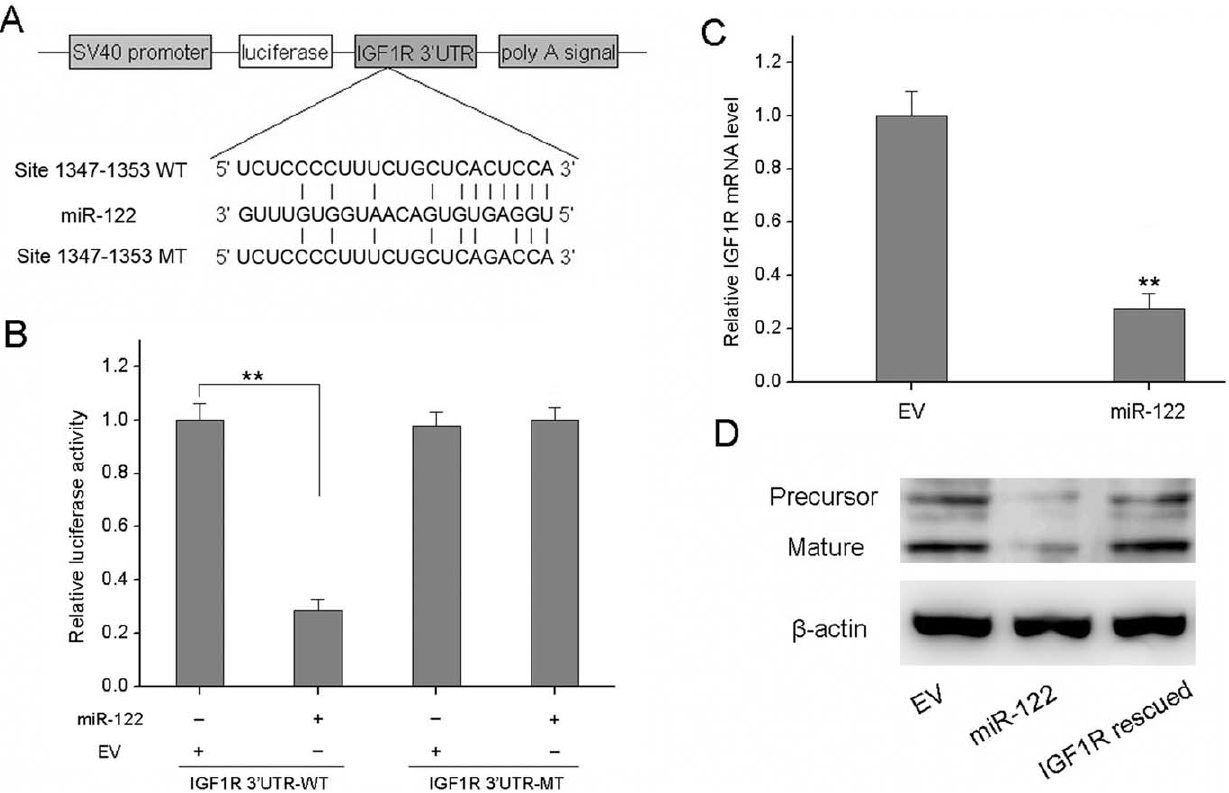
Figure 3. IGF1R is directly targeted by miR-122. (A) IGF1R 3 9 UTR and IGF1R 3 9 UTR-MT were inserted into the region immediately downstream of the luciferase gene in pGL3 vector. (B) Dual luciferase reporter assays were performed. The expression of the reporter containing IGF1R 3 9 UTR